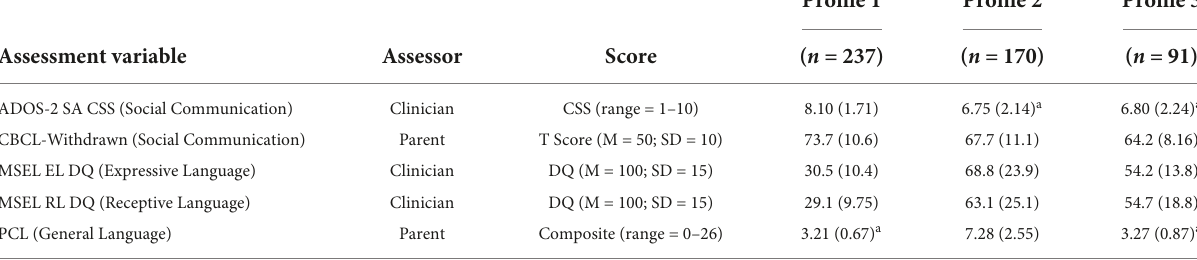
TABLE 2 Means and standard deviations of language and social communication variables by latent